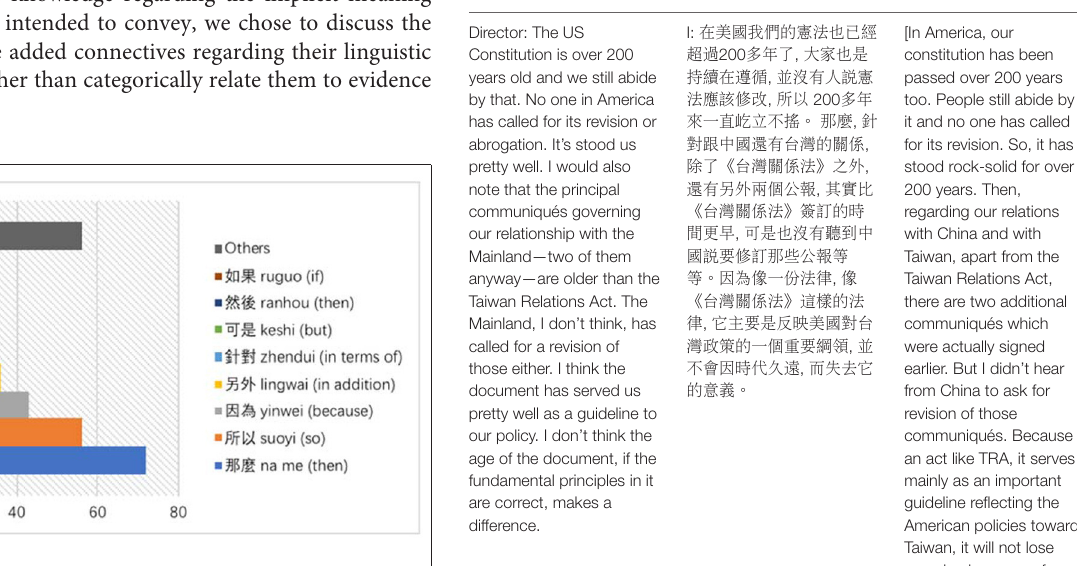
FIGURE 2 | Frequency of connectives added by